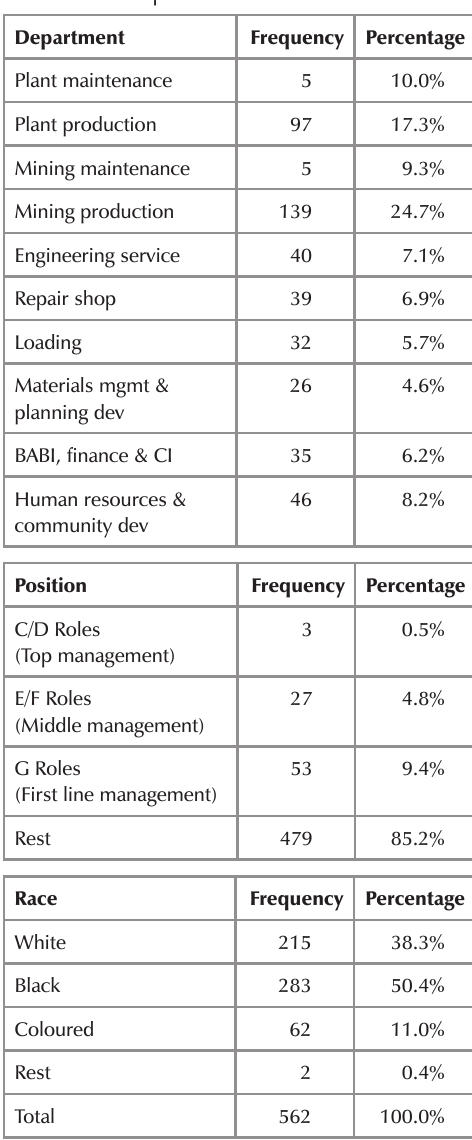
Breakdown of participants by